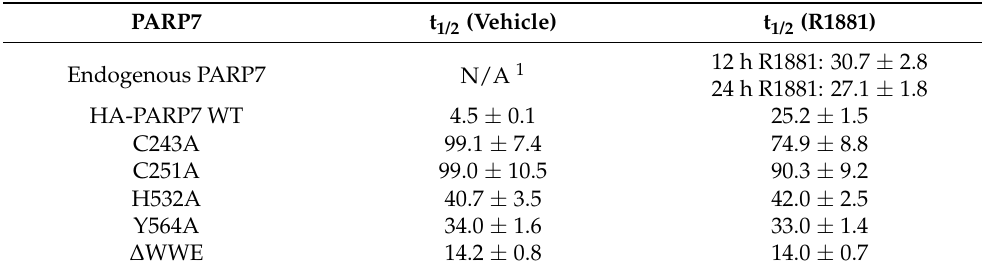
Table 1. Summary of PARP7 protein